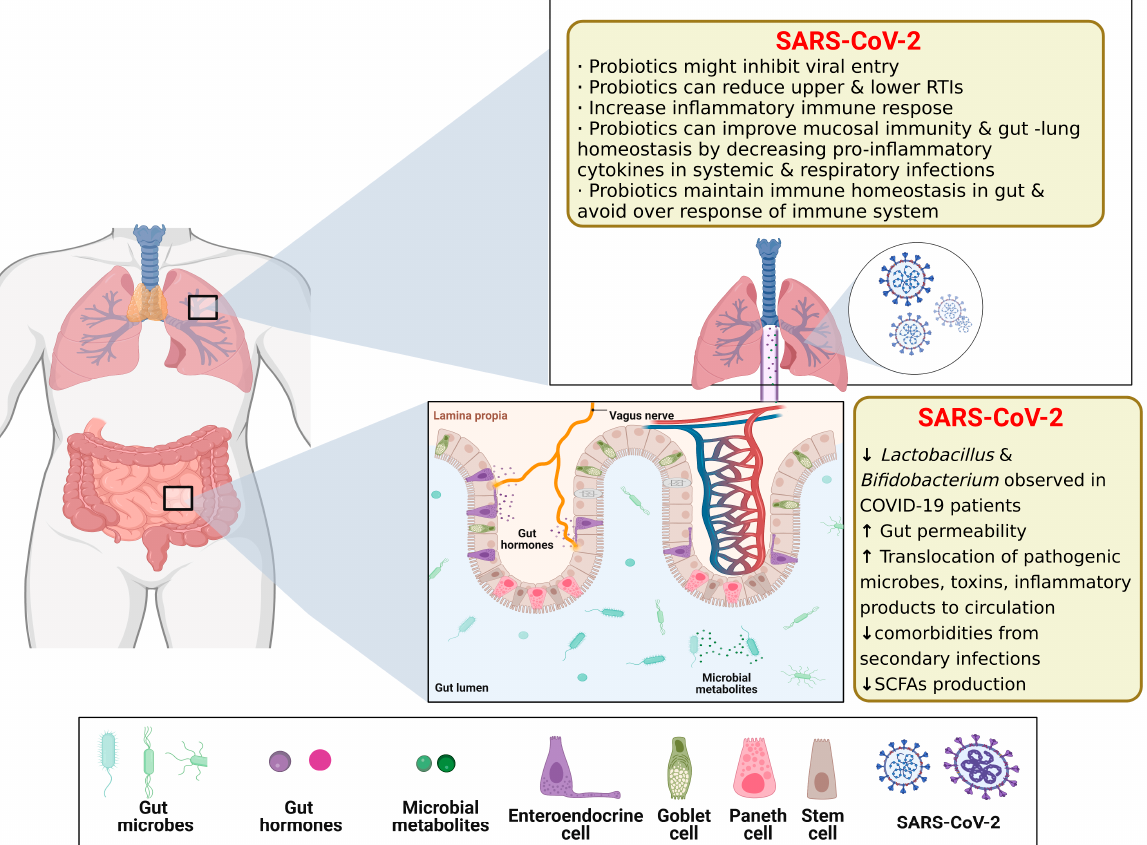
Figure 11. Schematics of Gut–lung Axis (GLAx). The gut luminal environment, including the gut microbiome, affects the physiology and behavior of the lung via multiple routes. Created with BioRender.com. The ↑ and ↓ arrows in the graph represent an increase or decrease in content, performance, relative abundance, and/or activity, respectively. The reproduction of this image has been licensed from BioRender.